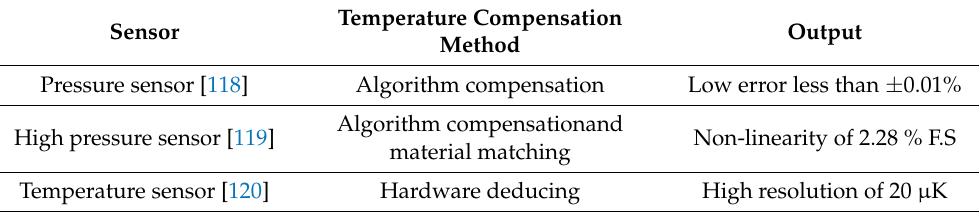
Table 9. Comparisons of PS-UCRB sensor.